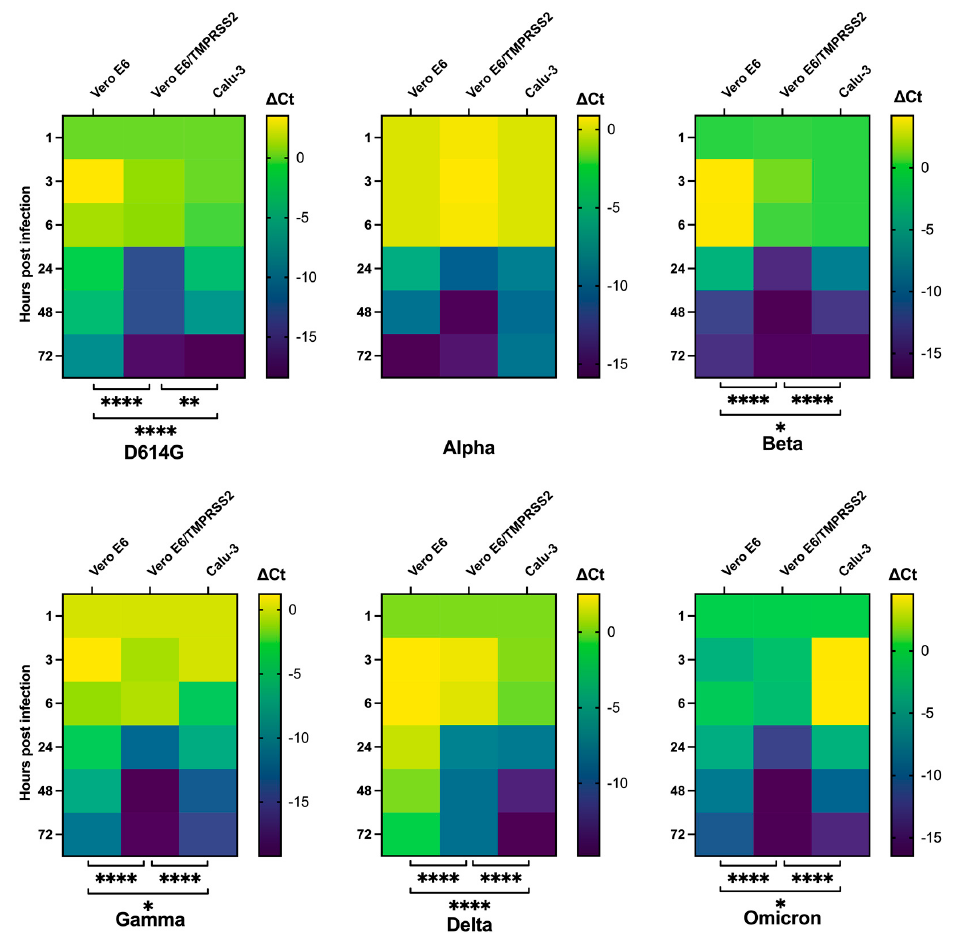
Figure 3. Replication kinetics trends of SARS-CoV-2 variants in the different cell lines. Heatmaps comparing Δ Ct values obtained from the three cell lines at the selected time points for the tested viral variants. The Δ Ct were reported as the mean values ± SD, * p < 0.05, ** p < 0.01 and **** p < 0.0001. Ct: threshold cycle.